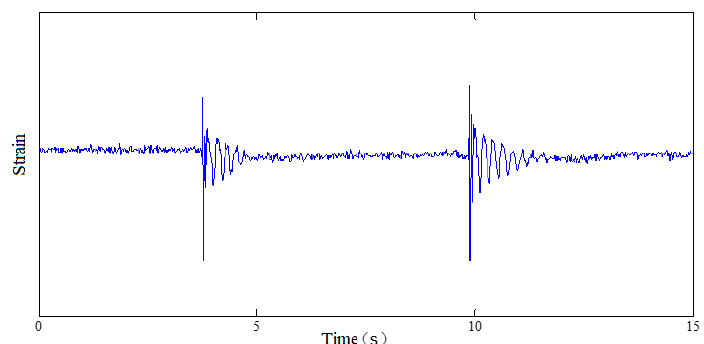
Figure 3. Strain response under beating.